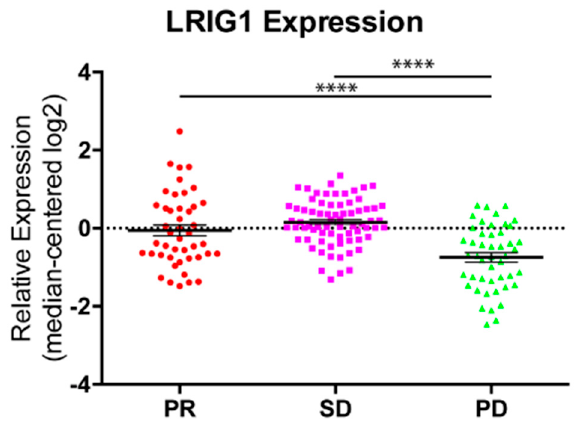
Figure 6. LRIG1 expression predicts resistance to cetuximab in colorectal cancer xenopatients. LRIG1 expression levels were evaluated in a cohort of CRC patients derived xenografts quadruple wild type for KRAS , BRAF , NRAS and PIK3CA , subdivided by response to cetuximab therapy: disease regression (PR), disease stabilization (SD), disease progression (PD). Ordinary one-way ANOVA was performed, with Tukey’s multiple comparisons test. **** p < 0.0001.